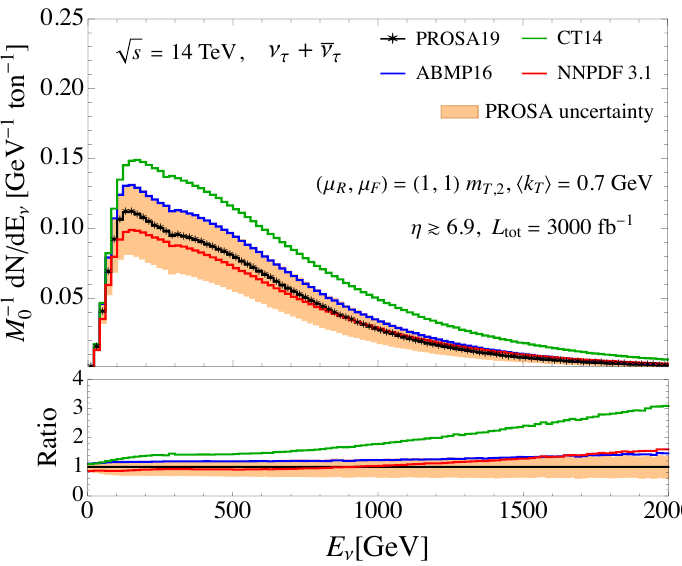
Figure 23. The same as figure 19 except for the pseudorapidity range and the integrated luminosity, which are set to η > 6 . 9 and L = 3000 fb − 1 ,